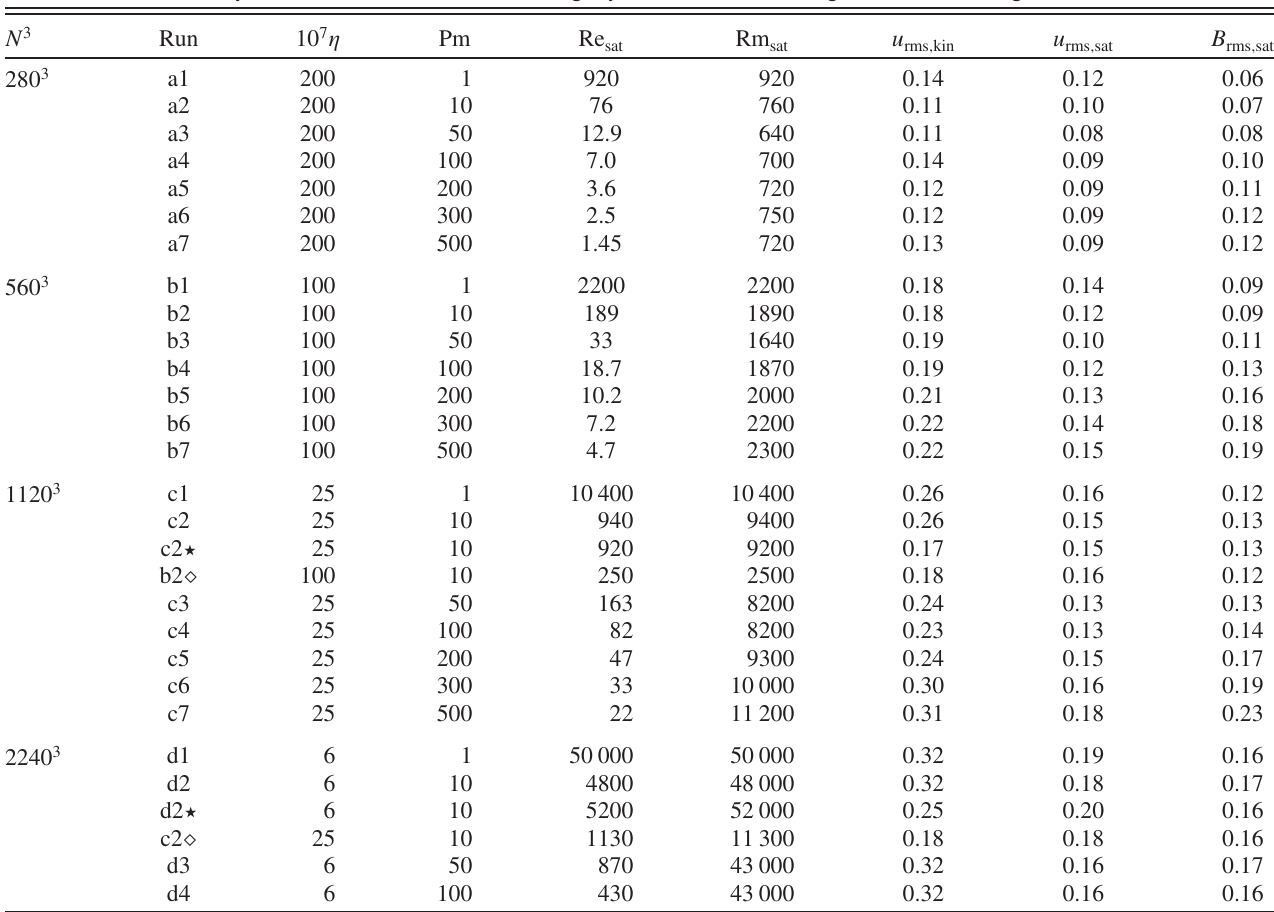
TABLE I. Run parameters at different resolutions N 3 . The subscripts “ sat ” and “ kin ” refer, respectively, to values measured during the saturated and kinematic stages. Versions of runs c2 and d2 using third-order Runge-Kutta time integration and third-order spatial reconstruction are also performed, here marked by a “ ⋆ . ” Versions of runs b2 and c2 with the same η and Pm but performed at twice the resolution are marked by a “ ⋄ . ” Runs with Pm ¼ 1 are slightly under-resolved during the kinematic stage. N